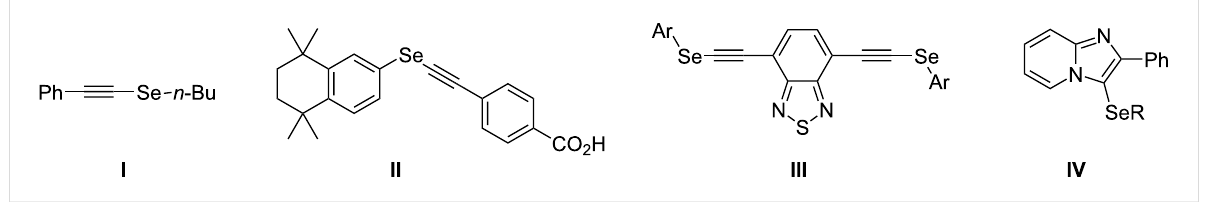
Figure 1: Biologically active selenides having alkynyl or imidazopyridinyl groups.